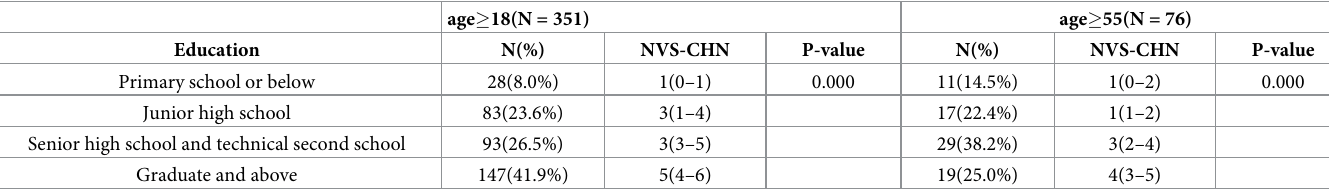
Table 2. NVS-CHN score comparison in different education level (Median